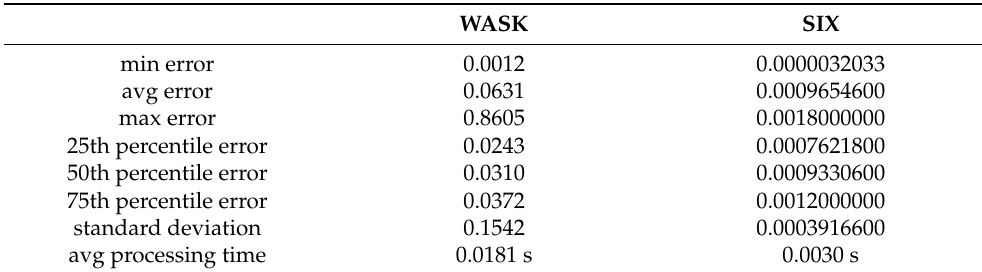
Table 2. Traffic modeling efficiency for WASK and SIX datasets.